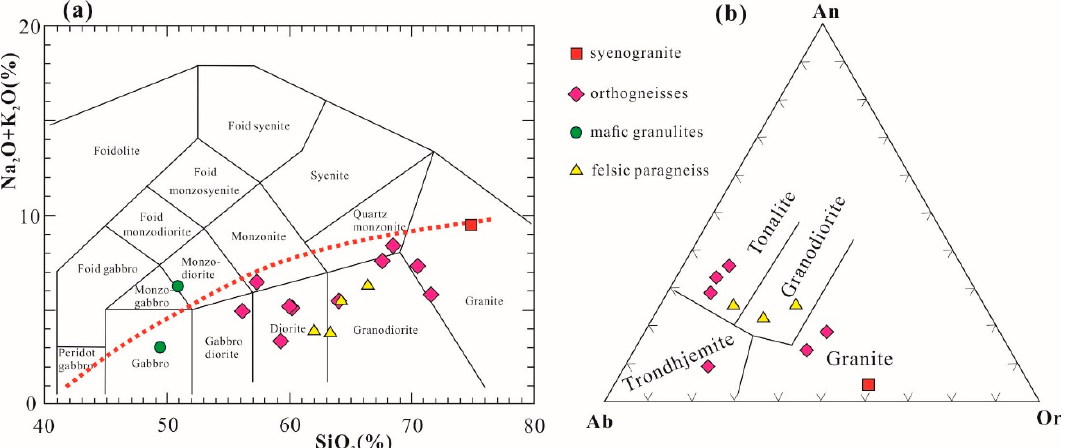
Figure 4. Geochemical classification diagrams for the analyzed representative samples in Eastern Hebei. ( a ) Total alkali versus silica (TAS) diagram [55]; ( b ) An–Ab–Or diagram [56].